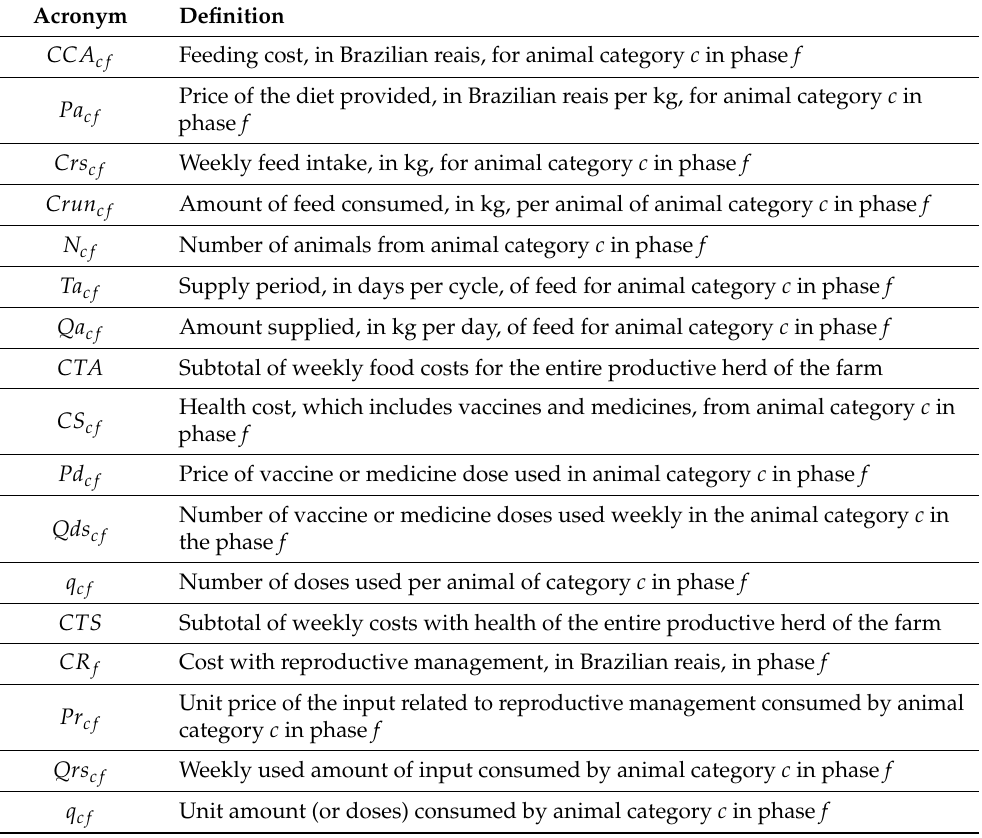
Table 3. Acronyms and definitions of formulas used to calculate the variable costs that compose the calculation model for swine